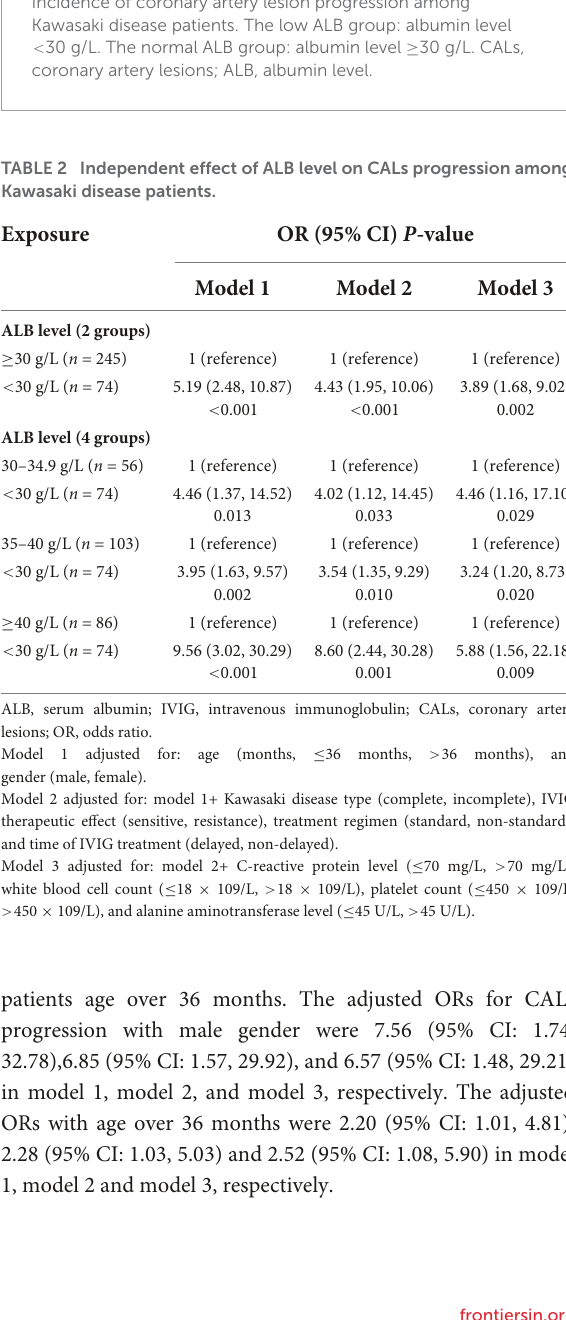
patients age over 36 months. The adjusted ORs for CALs progression with male gender were 7.56 (95% CI: 1.74, 32.78),6.85 (95% CI: 1.57, 29.92), and 6.57 (95% CI: 1.48,